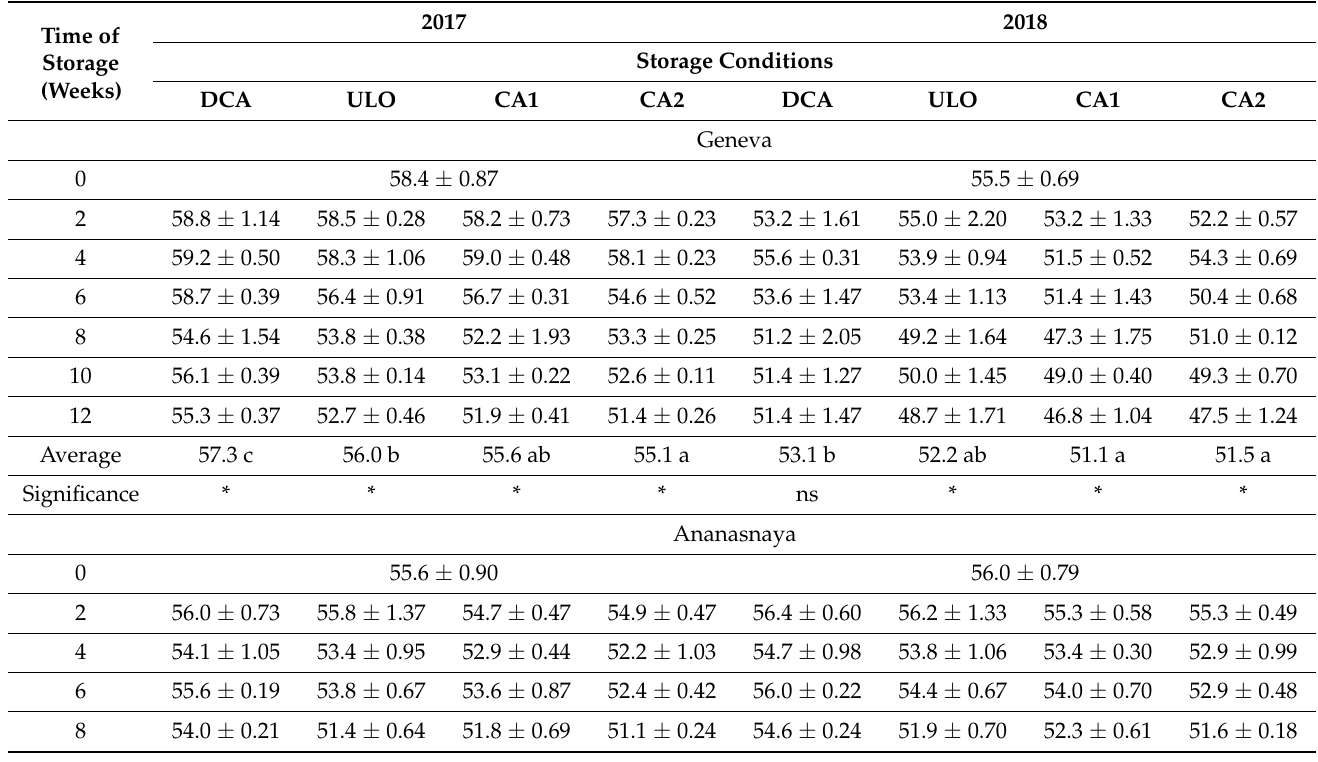
Table 10. Changes in skin color (parameter ‘L’) measured in ‘Geneva’ and ‘Ananasnaya’ minikiwi fruits in the postharvest